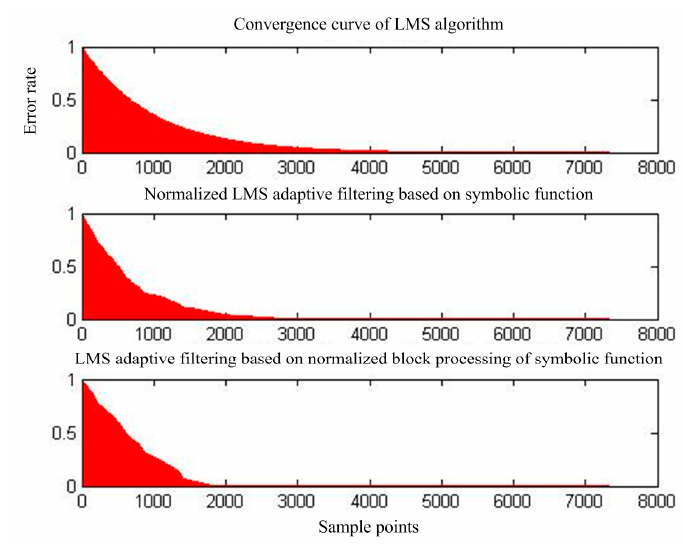
Figure 12. Convergence of mean square error of the three adaptive interference cancellation algorithms.